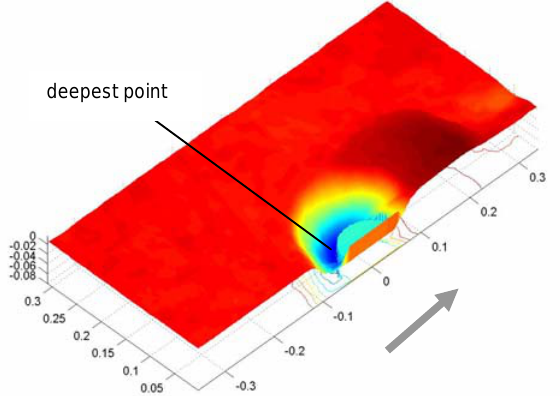
Figure 7. DEM after 17 Minutes. Flow is from lower left to upper